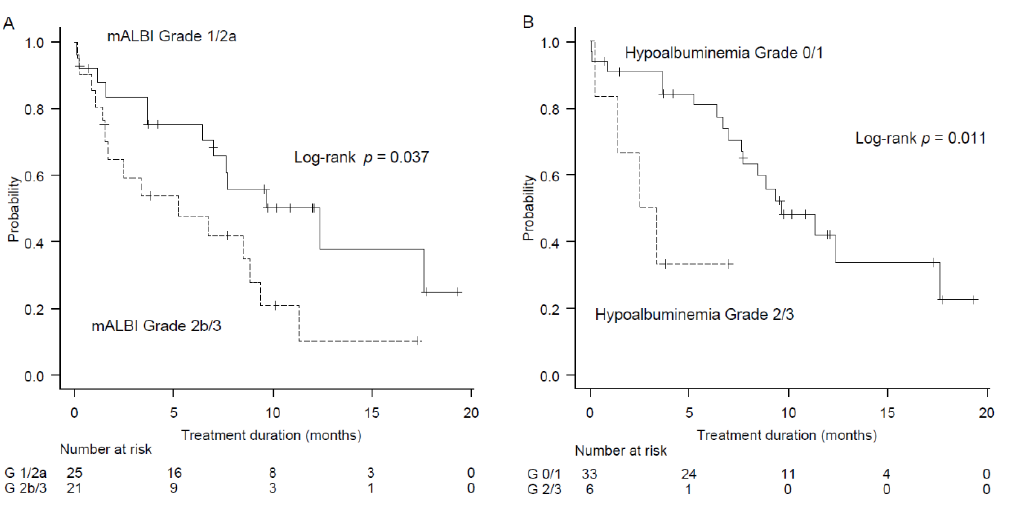
Figure 1. Factors associated with treatment duration. ( A ) The relationship between modified albumin bilirubin (mALBI) grade and treatment duration. ( B ) The relationship between hypoalbuminemia and treatment duration.